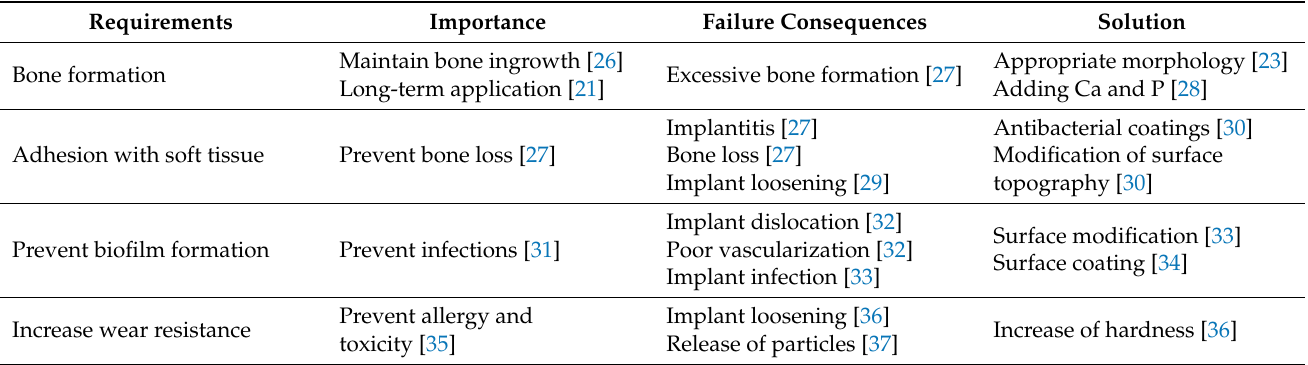
Table 1. Surface treatment